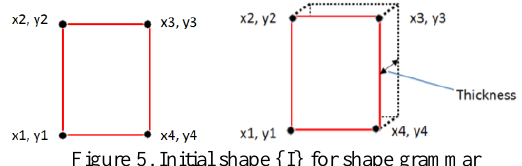
Figure 5. Initial shape {I} for shape grammar